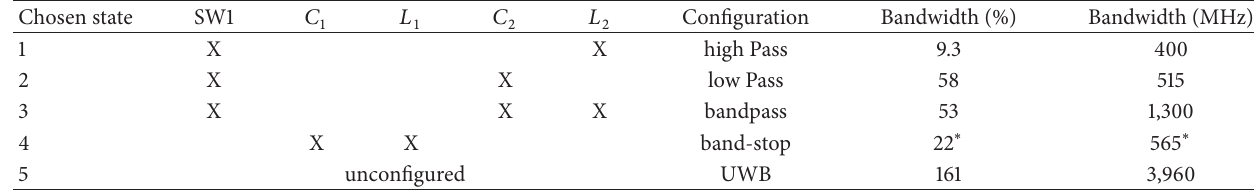
Figure 17: Equivalent circuit representation of the TCDA-IB array in Figure 5. The top graphic provides a one to one correspondence between the Marchand balun in Figure 2 and its equivalent transmission line circuit representation. The bottom circuit is a recasting of the equivalent ) and short circuit ( 𝑍 ) impedances of the balun itself. transmission line circuit into a more typical RF circuit showing the open ( 𝑍 OC SC Table 2: MTM array performance for various choices of the load termination of the open